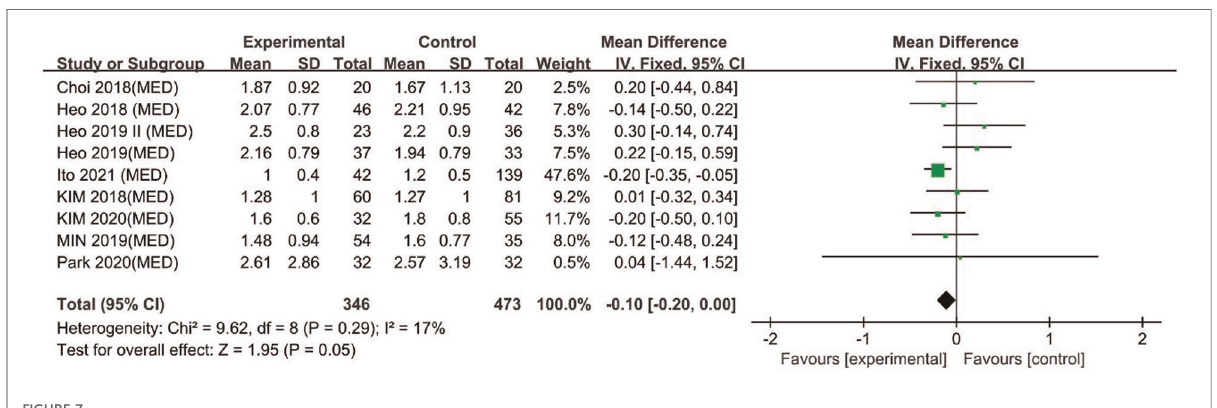
FIGURE 7 Forrest plot of long term vas leg pain UBE vs